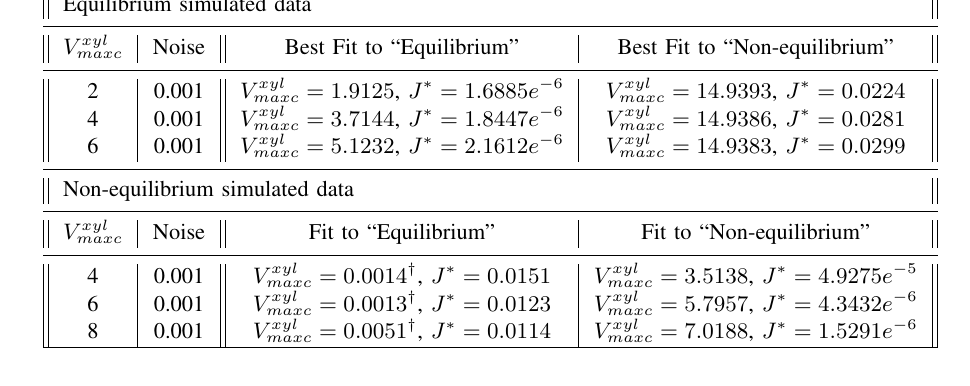
Non-equilibrium output using simulated equilibrium data